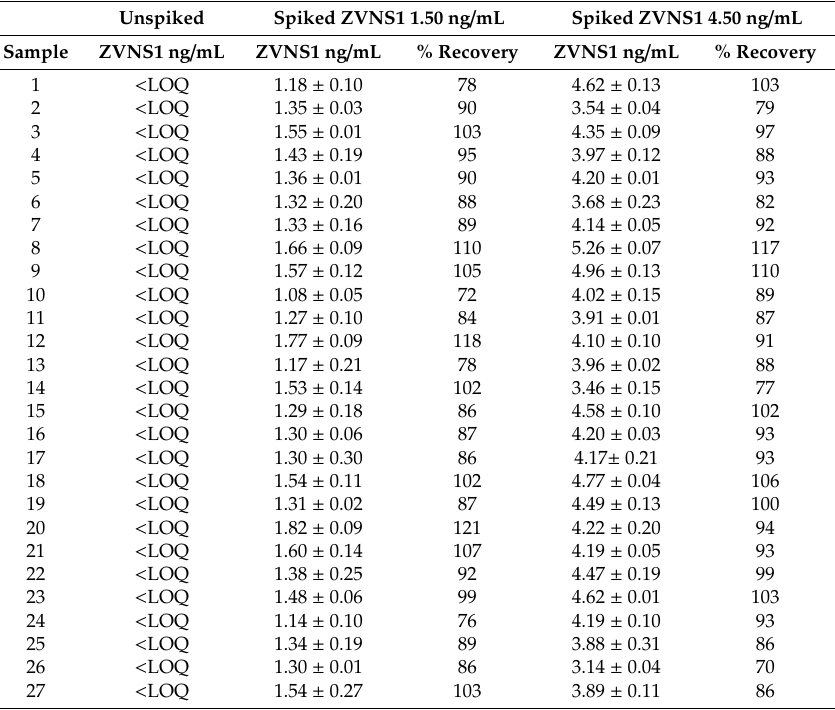
Table 1. Analysis of recovery in ZVNS1 spiked serum samples.